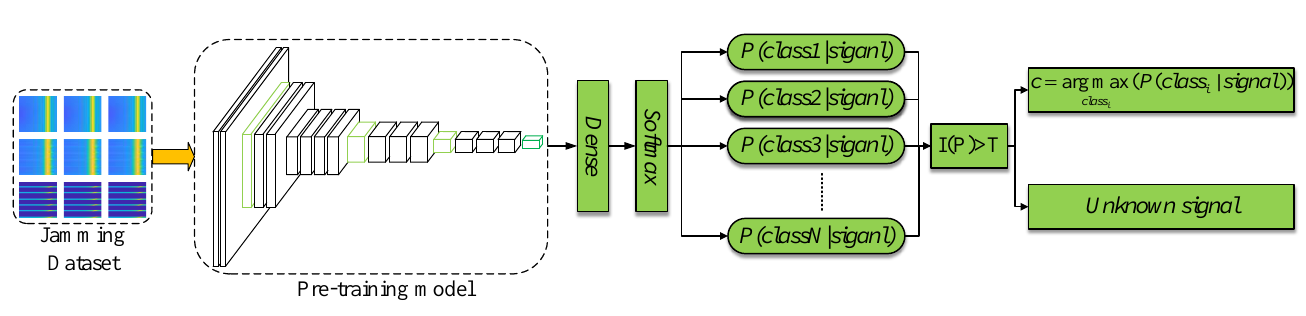
Figure 7. The structure of OSR model based on confidence score.